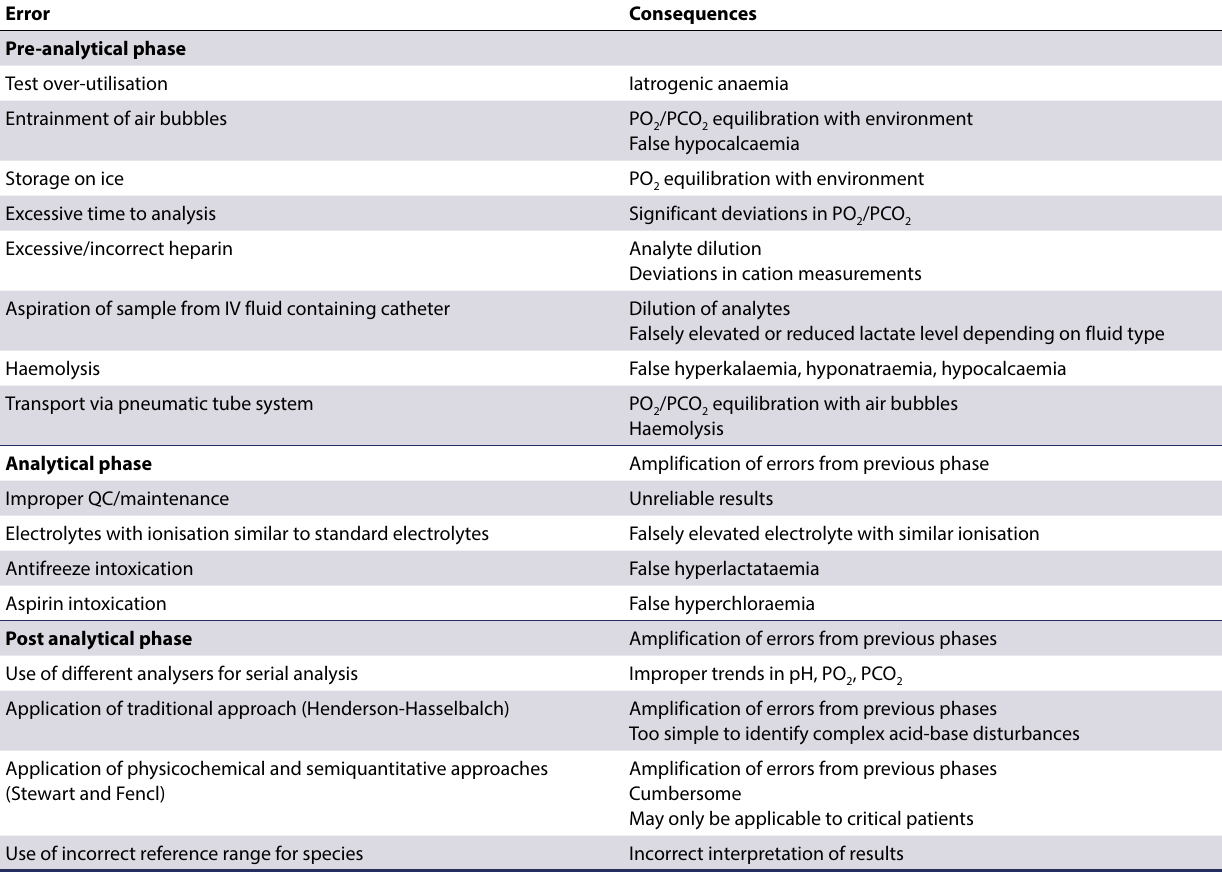
Table III: A summary of the sources of error and their consequences during blood gas analysis